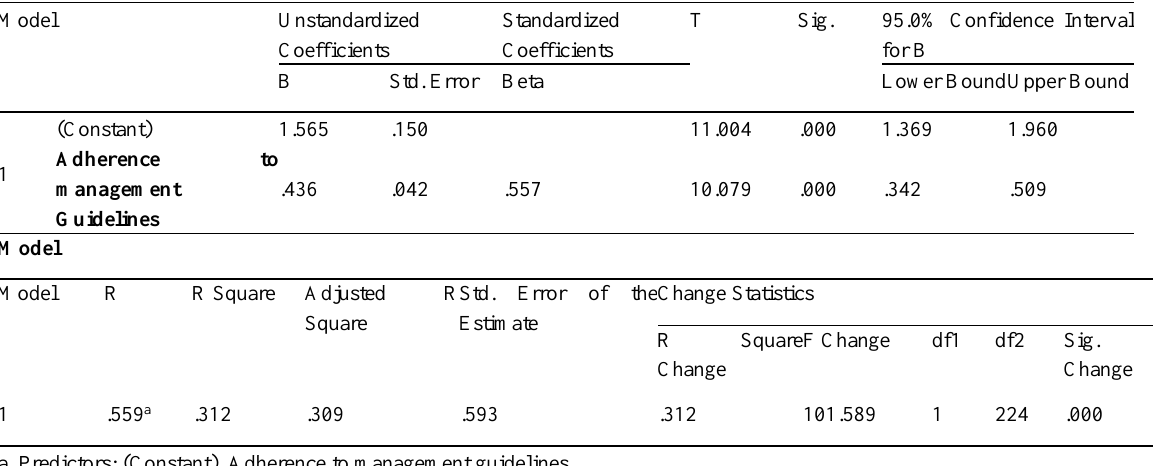
Table 5: Regression Results for the Effect of Adherence to Management Guidelines on Performance of Public